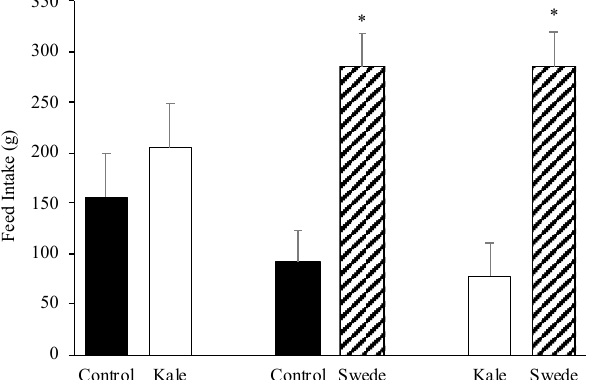
Figure 4. Least squares means (+ standard error) of pigs’ feed intake (g) of corn–soybean base diets with the inclusion of 15% of kale, swede, or wheat middlings (control diet) when animals were offered a two-feeder preference test during 10 min. * p < 0.05.